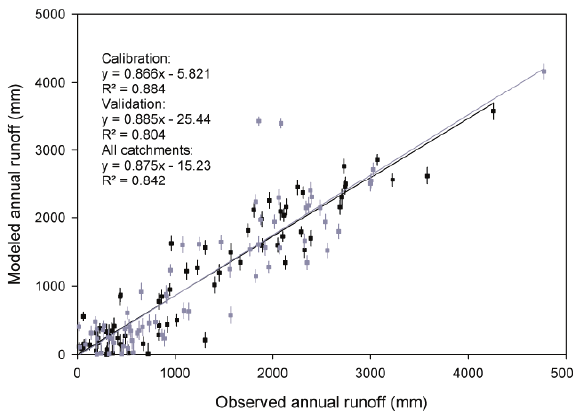
950 Fig. 3. Observed versus modeled annual runoff of catchments used for calibration 951 Fig. 3. Observed versus modelled annual runoff of catchments used (N=69, black dots), validation (N=69, gray dots), and all (N=138). Each dot 952 for calibration ( N =69, black dots), validation ( N =69, gray dots), represents observed average annual runoff for one catchment. The error bar 953 and all ( N =138). Each dot represents observed average annual represents the effect on modeled runoff of a ±10% change in catchment 954 runoff for one catchment. The error bar represents the effect on evapotranspiration to account for the mismatch between current and potential 955 modelled runoff of a ± 10% change in catchment evapotranspiration vegetation cover simulated by MAPSS. 956 to account for the mismatch between current and potential vegeta- tion cover simulated by MAPSS.